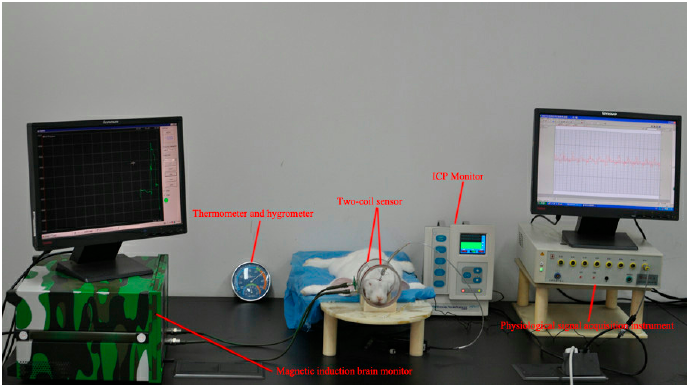
Figure 4. Experimental setup to monitor cerebral edema in rabbits with the MIPS method.